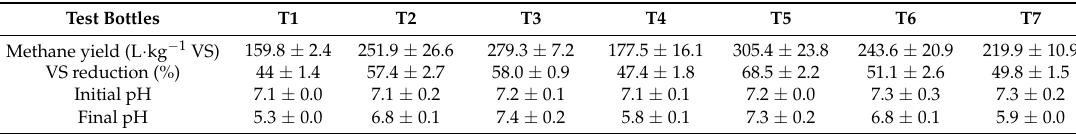
Figure 4. The Total Volatile Fatty acids (TVFA) and pH at the end of the codigestion tests (the data represented are the average values of triplicate bottles. The error bars represent the standard deviation). Table 5. The effect of codigestion on digester